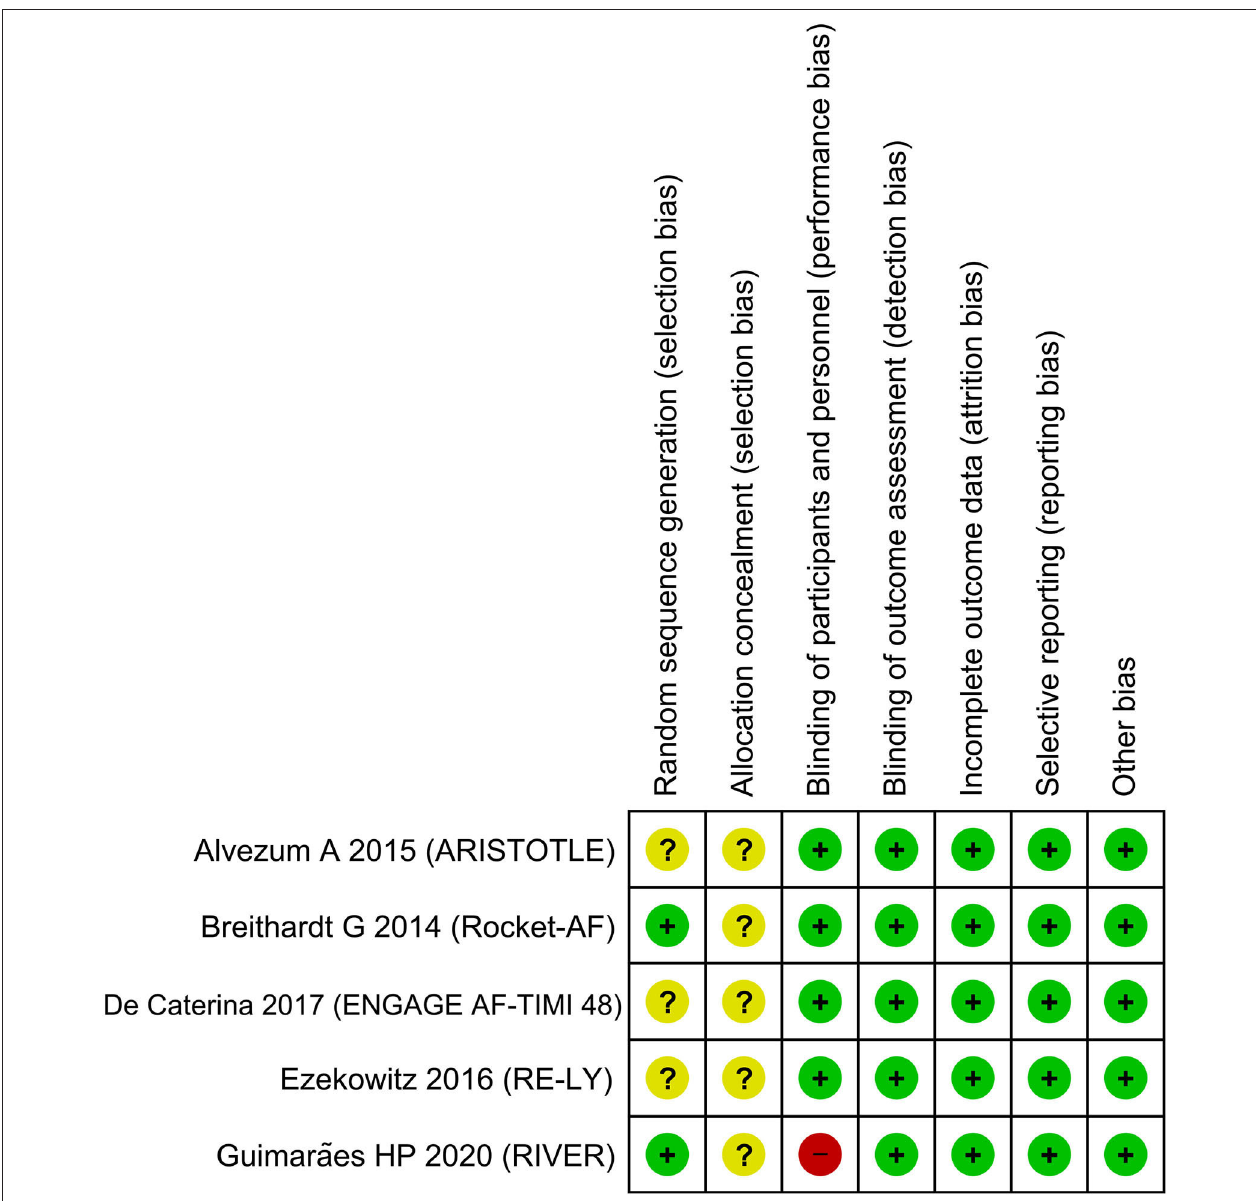
FIGURE 6 | Risk of bias assessment.